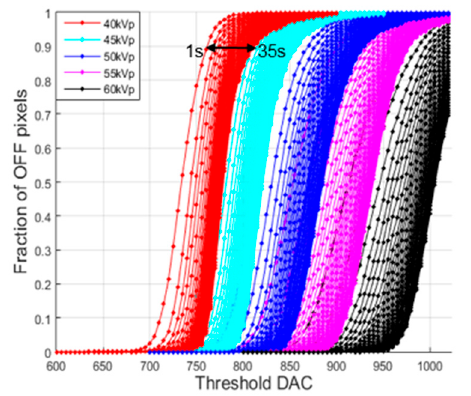
Figure 4. The fraction of OFF pixels with respect to the threshold DAC observed with the tube voltages of 40, 45, 50, 55 and 60 kVp. The tube current was 200 μ A and the exposure time was varied from 1 s to 35 s.